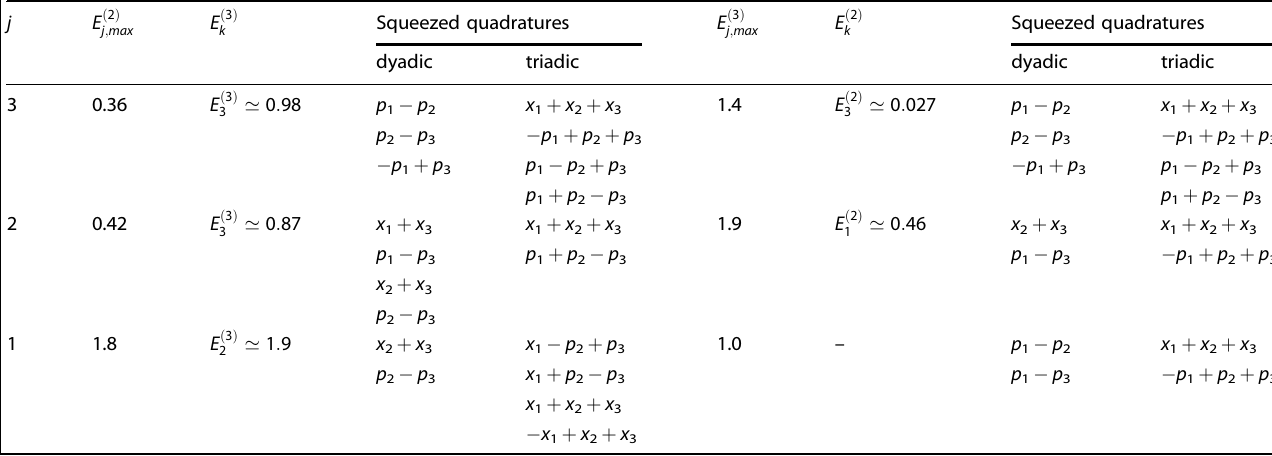
Table 1. Interplay of dyadic and triadic entanglement and squeezed collective quadratures. The left half shows results for maximum dyadic entanglement E ð 2 Þ , including the corresponding triadic entanglement and the dyadic and triadic collective quadratures that are squeezed below j ; max the shot-noise level. The right half shows the squeezed quadratures and corresponding dyadic entanglement for the maxima of triadic entanglement E ð 3 Þ . To keep the notation concise, the collective quadratures are not j ; max